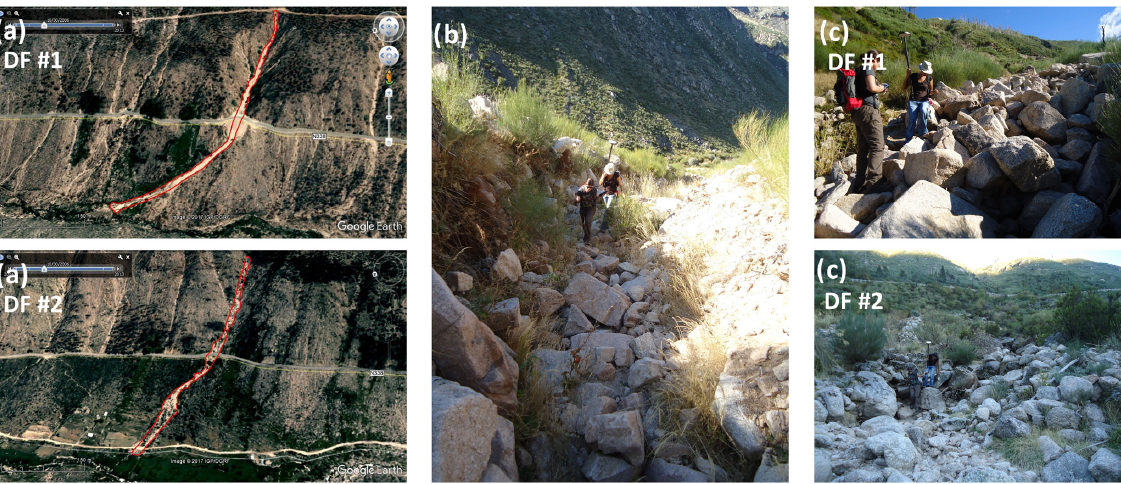
Figure 3. (a) Debris flow identification and delimitation; (b) material deposited in the transport zone; (c) deposits in the accumulation area.